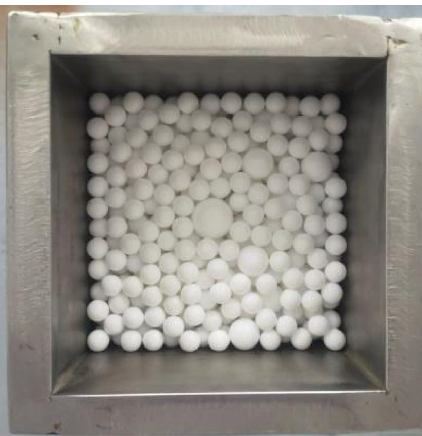
Figure 3: Specimen with